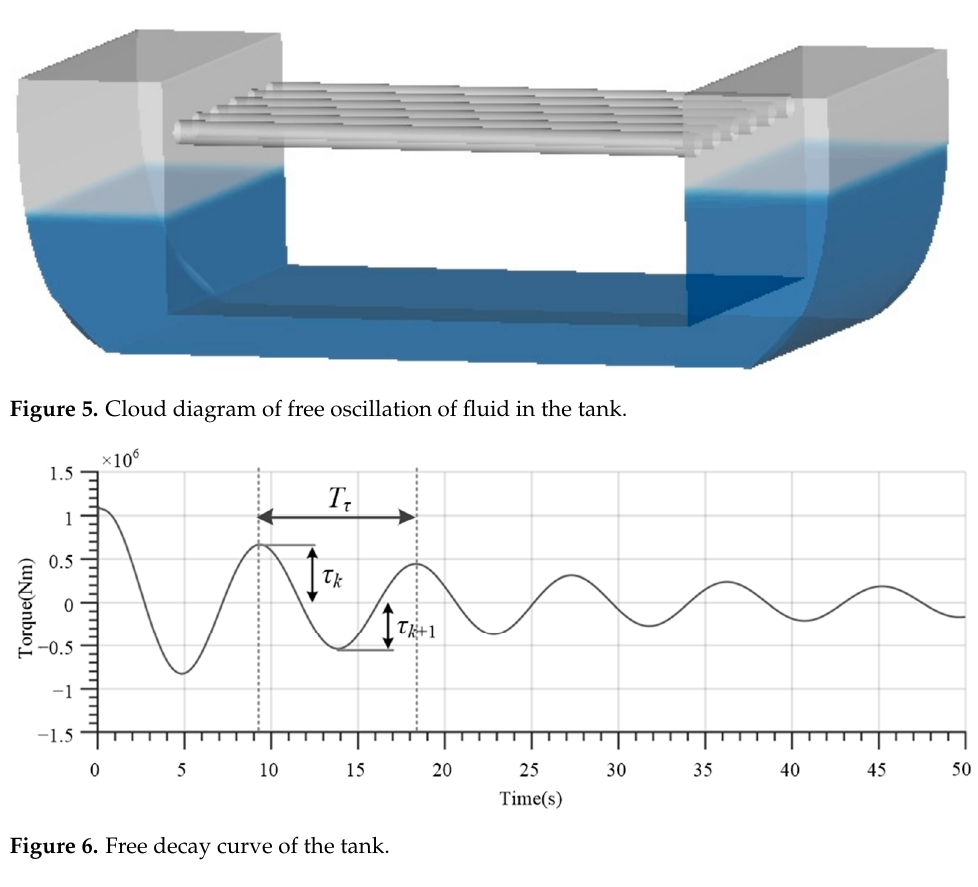
Figure 6. Free decay curve of the tank.